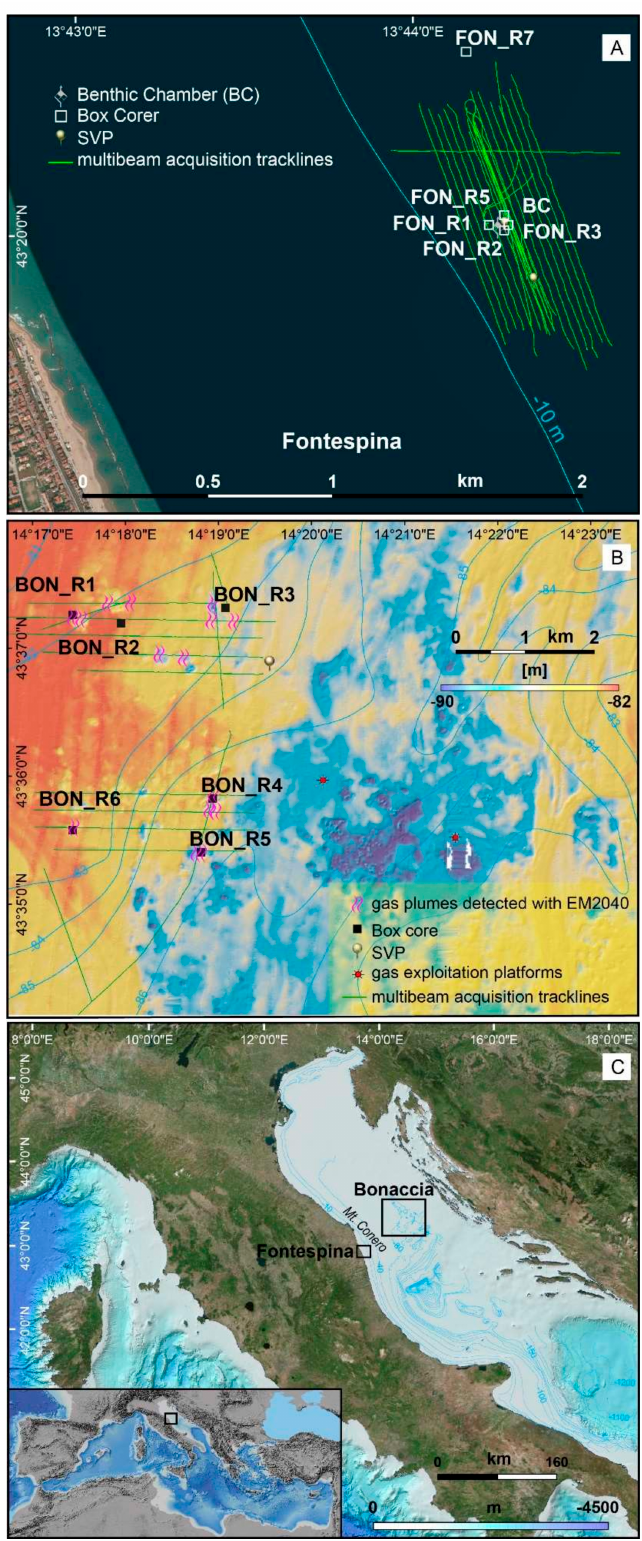
Figure 1. The Fontespina ( A ) and Bonaccia ( B ) study areas and sampling sites in the Central Adriatic Sea ( C